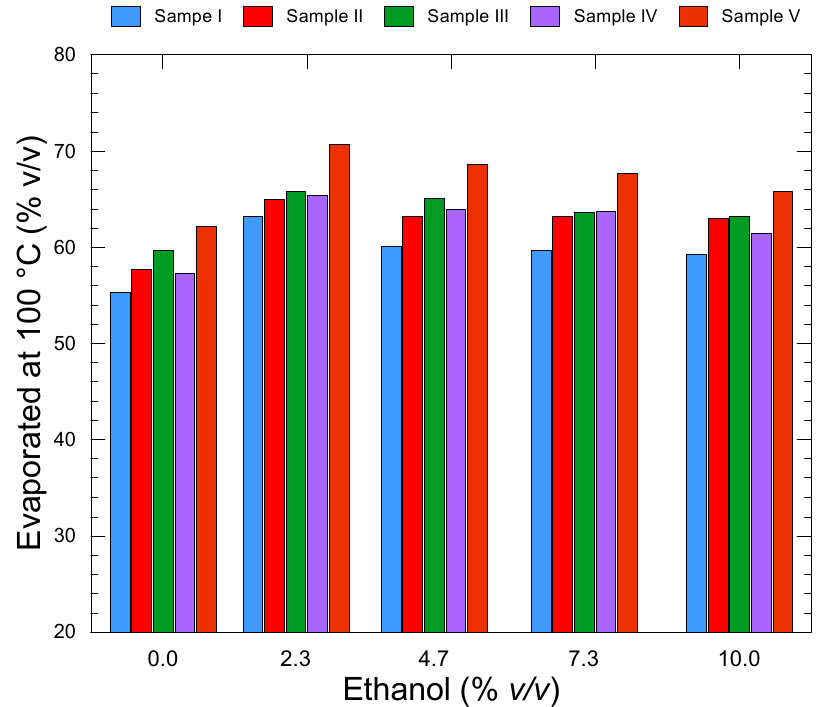
Figure 9. E100 values for all blends against bio-ethanol content.